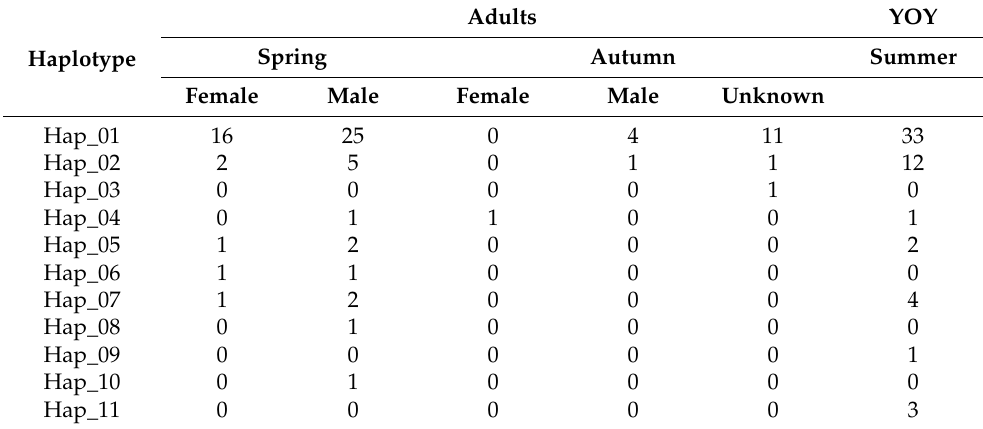
Table 3. Absolute frequency of haplotypes by migration season, developmental stage and gender.